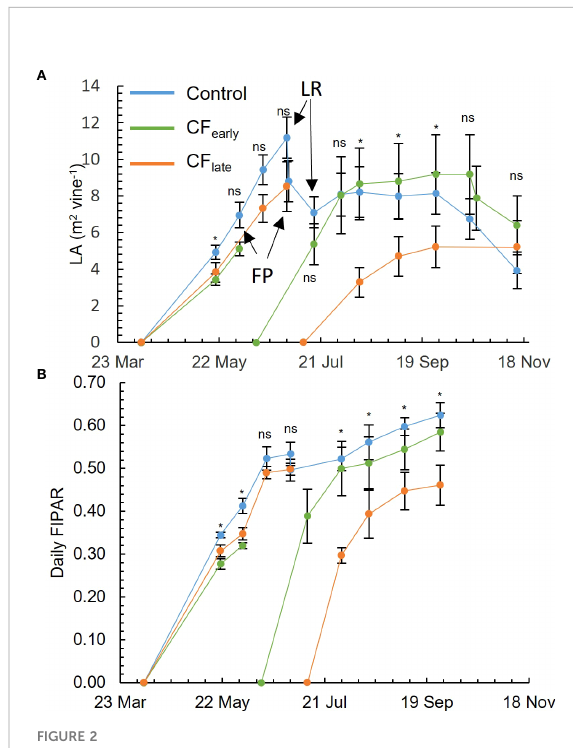
FIGURE 2 Seasonal evolution for 2019 of leaf area (LA). FP, forcing pruning; LR, leaf and shoot removal, only affecting control treatment (A) . Daily fraction of intercepted radiation (FIPAR) evolution for each treatment modelled according to the Oyarzun et al. (2007) model (B) . Blue, green, and orange lines correspond to Control, CF early and CF late treatments, respectively. Each plot is the average of four vines for each treatment. Bars mean standard deviation. Treatment effects were analysed using ANOVA at P< 0.05. ns, not signi fi cant; *=signi fi cant.